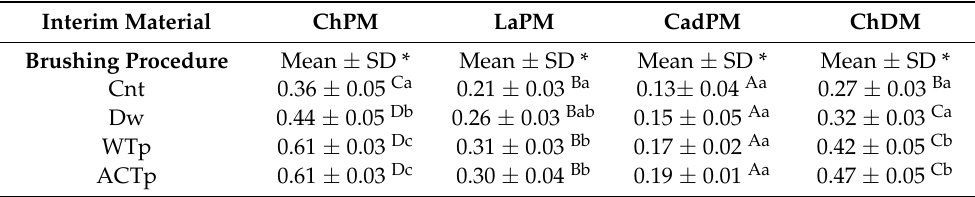
Table 3. Mean R a values ( µ m) and standard deviations (SD) of test groups with Tukey’s HSD multiple